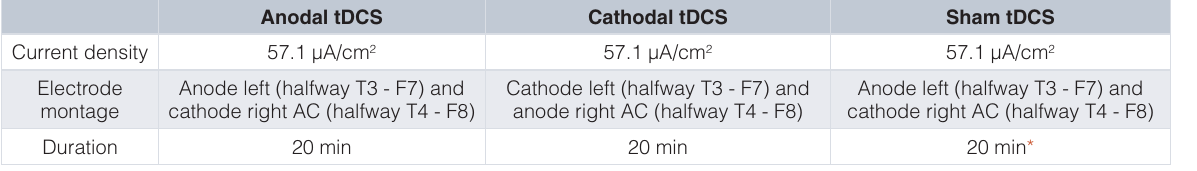
Table 1. Setting for anodal, cathodal, and sham Transcranial Direct Current Stimulation